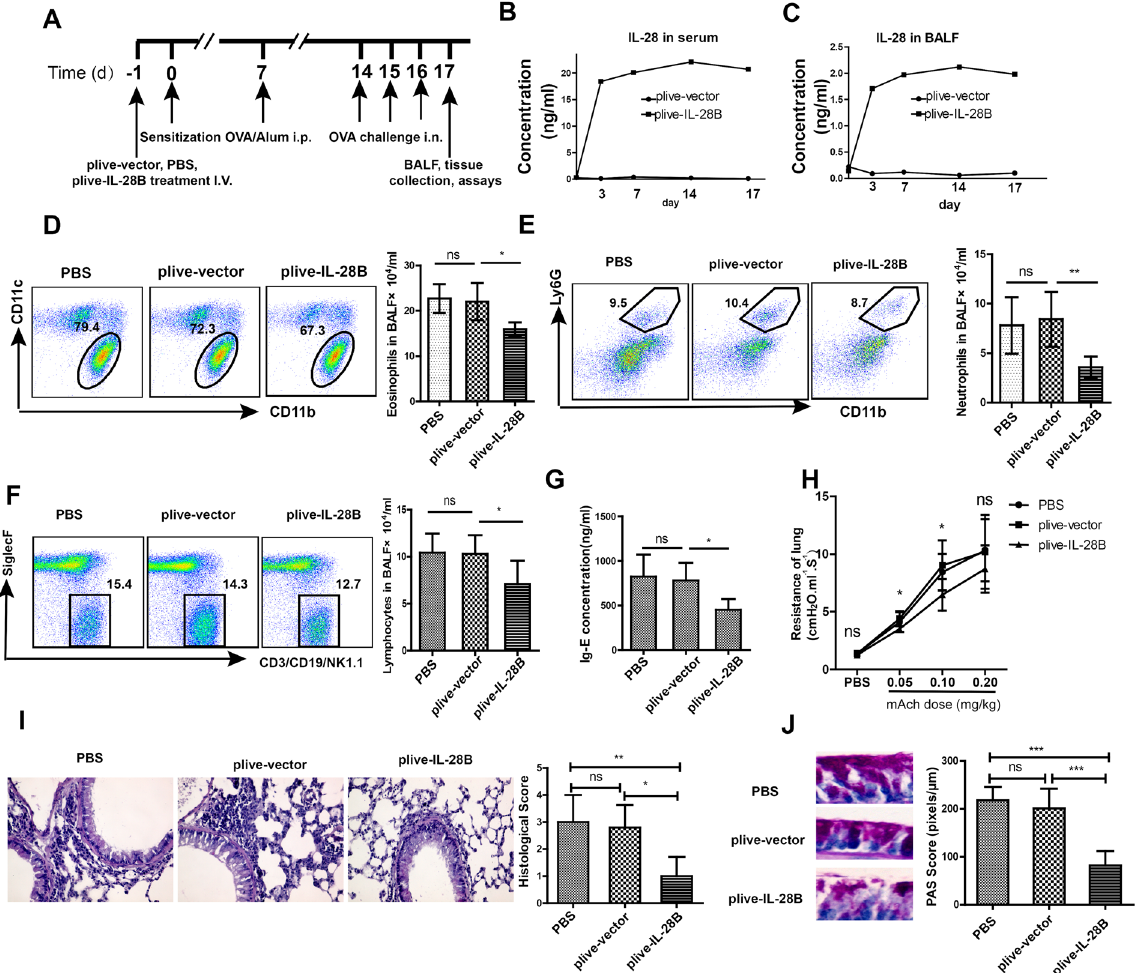
Figure 1. IL-28B suppressed OVA-induced airway inflammation. ( A ) Schematic timeline for OVA induction of asthma and plive-IL-28B injection. ( B ) and ( C ) Time-course expression of IL-28B in serum ( B ) and BALF ( C ). ( D–F ) Flow cytometry and cell counting assays for abundance and numbers of eosinophils ( D ) neutrophils ( E ) and lymphocytes ( F ) in BALF. ( G ) The inhibitory effect of plive-IL-28B on IgE production. ( H ) The effect of plive-IL-28B on the airway resistance in the mouse lung. ( I ) Histological assessment of lung inflammation in PBS-, plive-vector- or plive-IL28B- treated asthmatic mice. ( J ) PAS staining for mucus production in lung epithelium of PBS-, plive-vector- or plive-IL28B- treated asthmatic mice. PBS is phosphate buffer saline. OVA is ovalbumin. Alum is aluminum. BALF is bronchoalveolar lavage fluid. I.V. is intravenous injection. i.p. is intraperitoneal injection. i.n. is nasal inhalation. mAch is muscarinic acetylcholine. PAS is Periodic Acid-Schiff stain. H&E is hematoxylin-eosin staining. * p < 0.05; ** p < 0.01; *** p < 0.001; ns: non-significant ( n = 5 mice per group). Results shown are representative of three independent